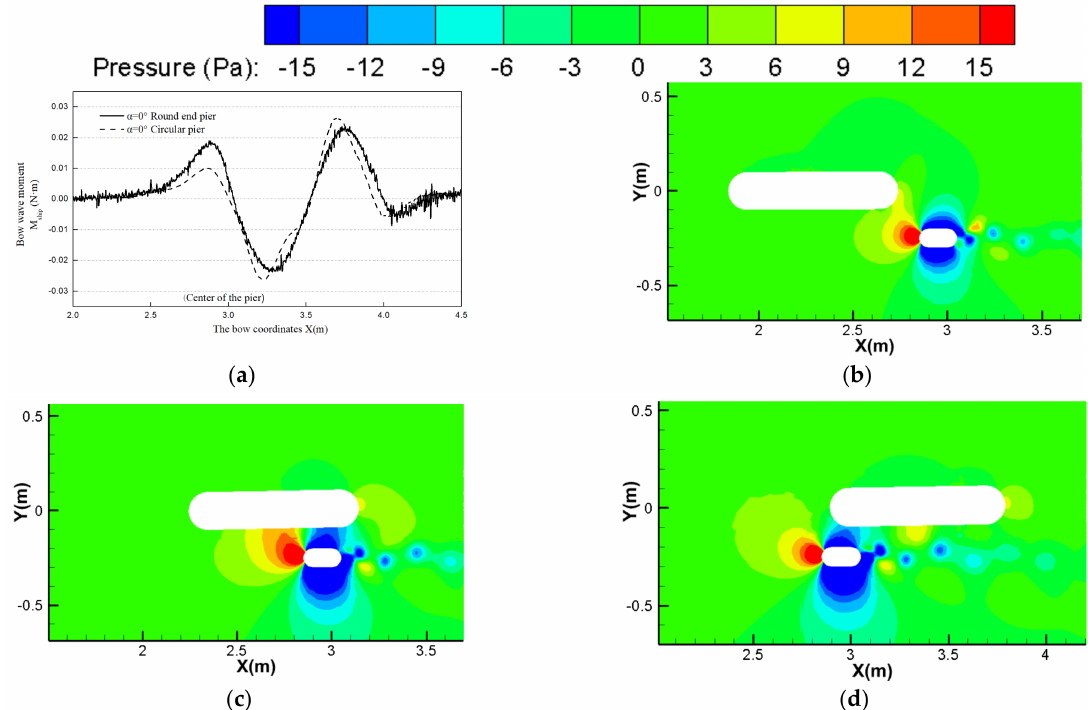
Figure 27. Diagrams of the flow pressure distribution and bow roll moment variation of a ship moving through a circular-ended pier at α = 0 ◦ : ( a ) Variation law of the bow roll moment; ( b ) Ship bowled up to the pier; ( c ) Bow moving over the pier; ( d ) Stern moving over the pier.